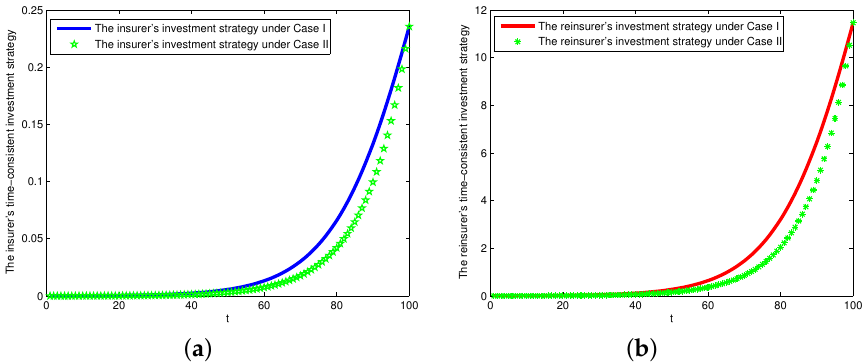
Figure 4. Nash equilibrium investment strategies for ( a ) the insurer and ( b ) the reinsurer ( α = 0.8 and x = 1.01).